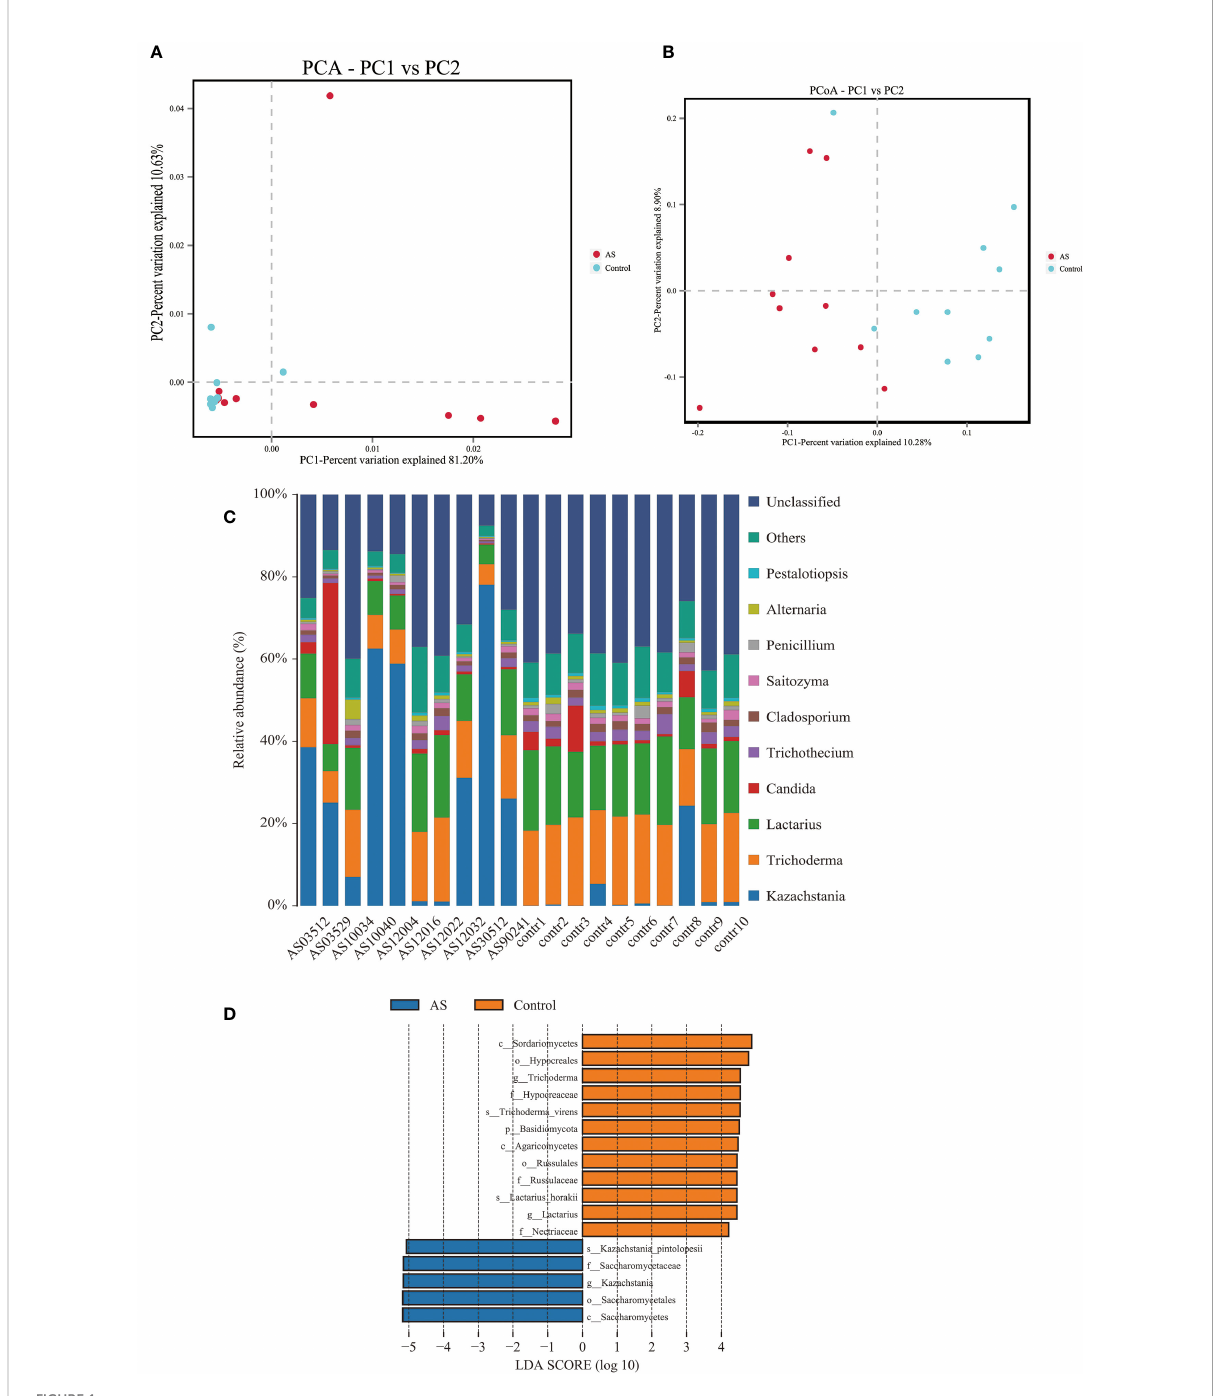
FIGURE 1 Altered mycobiota biodiversity and composition in AS monkeys. (A) Principal Component Analysis (PCA). Note: Dot represents each sample. Different colors represent different groups. The abscissa represents the fi rst principal component, and the percentage represents the contribution value of the fi rst principal component to the sample difference. The ordinate represents the second principal component, and the percentage represents the contribution of the second principal component to the sample difference. (B) Principal-coordinate analysis (PCoA) using the binary Jaccard distance algorithm. The horizontal and vertical coordinates are the two characteristic values that lead to the largest difference between samples, re fl ecting the major in fl uence degree in the form of a percentage. (C) Global composition of fungal microbiota at the genus levels showing in bar chart. The more details see also in Figures S1, S2. (D) LEfSe (Line Discriminant Analysis (LDA) Effect Size) of AS and health monkeys. Note: The fi gure shows species whose LDA Score is greater than the set value (the default setting is 4.0). The length of the bar chart represents the size of the impact of different species (i.e., LDA Score). Different colors represent species in different